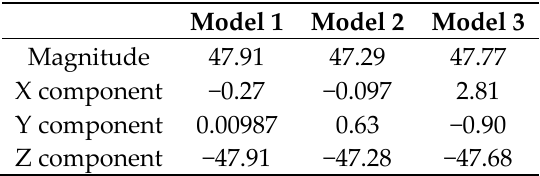
Figure 5. Force reaction between the ball and string-bed. Table 2. Force magnitude and components (N) for the three